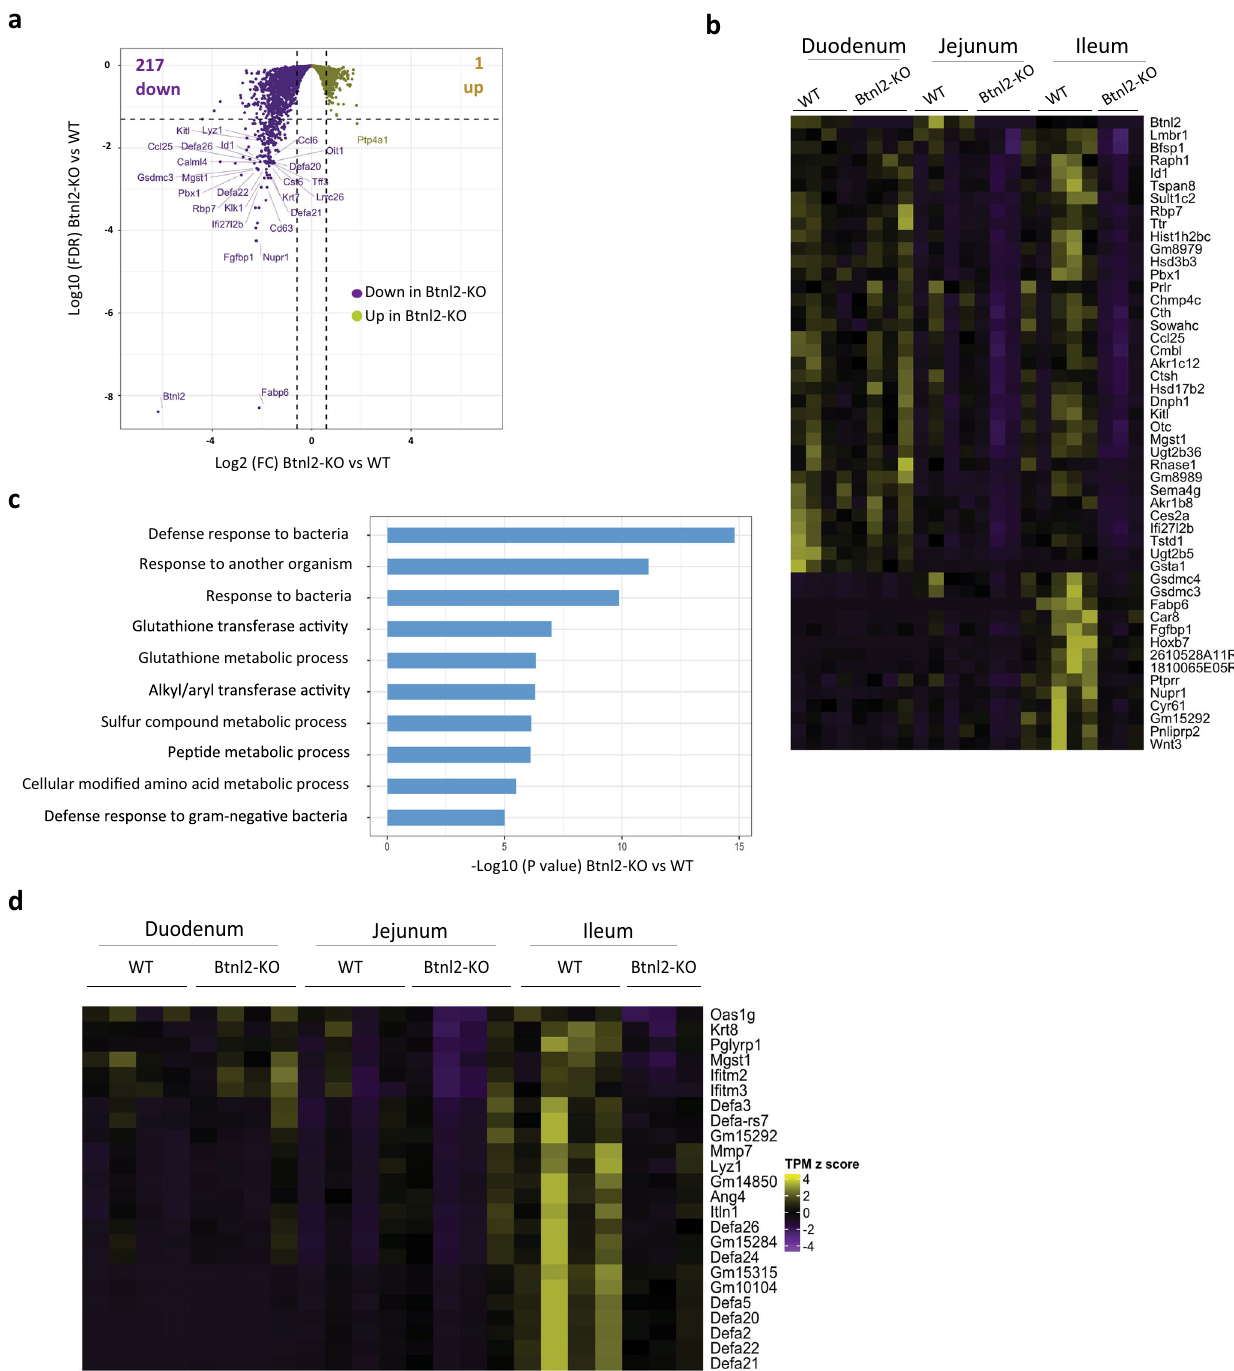
Fig. 4 Ileal Btnl2-KO γδ IELs display an altered antibacterial response module compared to ileal WT γδ IELs. γδ IELs from duodenum, jejunum, and ileum of cohoused 11-week-old Btnl2-KO and WT littermates ( n = 3 – 4/genotype, each a pool of 2 mice) were sort-puri fi ed as CD45 + TCR β -TCR γδ + cells. RNA sequencing was performed, and gene set enrichment analysis using NextBio. Gene ontology (GO) was employed to identify GO biological processes differentially enriched in Btnl2-KO and WT γδ IELs. a Volcano plot displaying genes differentially regulated between ileal Btnl2-KO and WT γδ IELs. The Horizontal dashed line indicates FDR = 0.05 and a vertical dashed line indicates |Fold Change | = 1.5. b Hierarchical clustering of top 50 differentially expressed genes between ileal Btnl2-KO and WT γδ IELs; duodenal and jejunal Btnl2-KO and WT γδ IELs were also included as a comparison. c Gene ontology enrichment analysis of most signi fi cantly impaired biological processes in ileal Btnl2-KO γδ IELs compared to ileal WT γδ IELs. d Hierarchical clustering of top dysregulated antibacterial response genes in ileal Btnl2-KO and WT γδ IELs within the combined top 3 GO processes; duodenal and jejunal Btnl2-KO and WT γδ IELs were also included as a